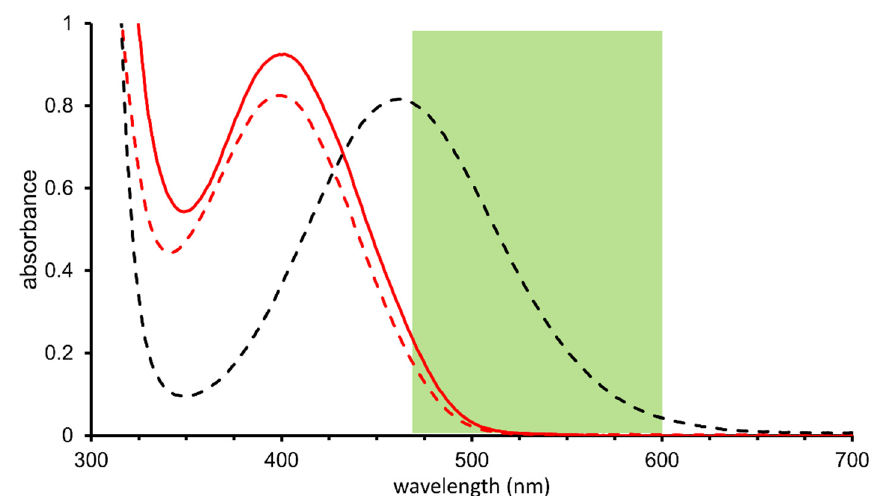
Figure 4. UV-Visible absorbance spectra in DCE of Bis-TEMPO-Vis (red continuous, 0.33 mM), and CF 3 -Bis-TEMPO-Vis (red dashed, 0.33 mM) and TEMPO (black dashed, 75.0 mM) with the green LED emission region (470–600 nm) shaded. The higher concentration of TEMPO is to demonstrate free TEMPO absorption, and the inadequacy of TEMPO as a radical trap in kinetic studies [4] .